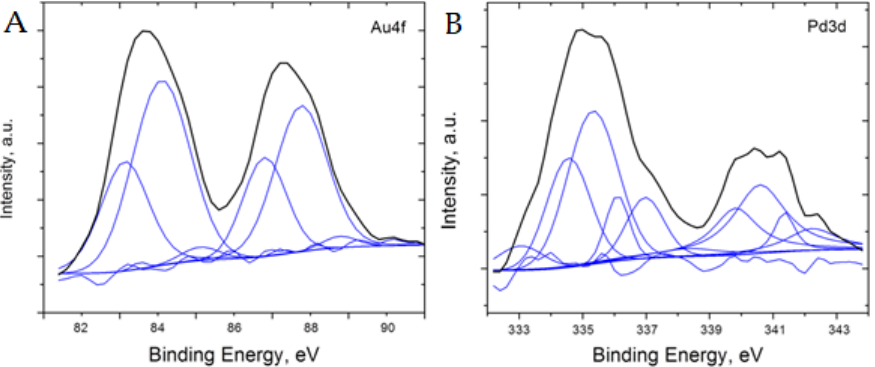
Figure 8. Core level XPS spectra of Au ( A) and Pd ( B ) after the charge and background correction for 5%Pd-5%Au/SiO 2 catalyst.